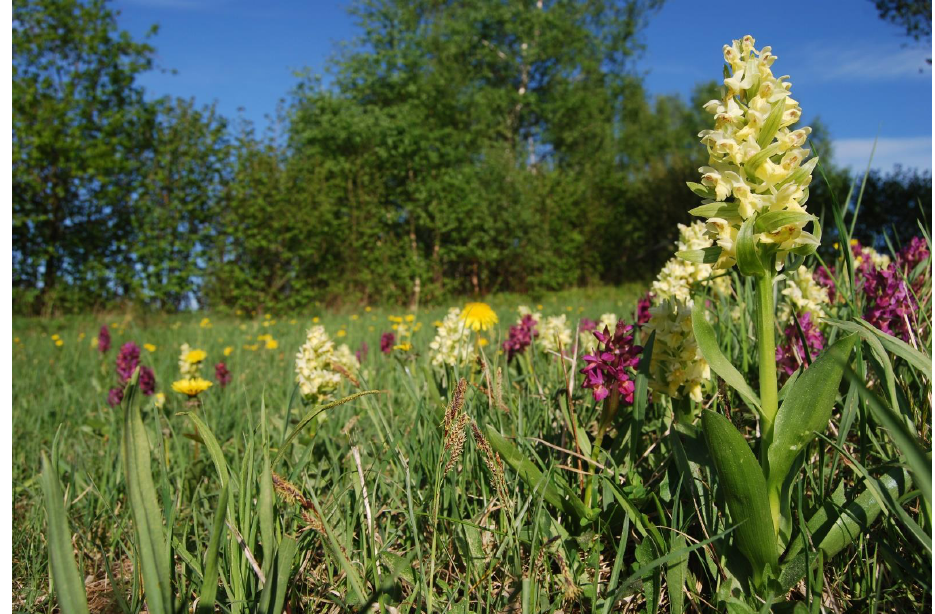
Figure 1. Dactylorhiza sambucina flowering in a Waldviertel population. The photograph shows yellow- and red-flowering individuals, which were monitored in ten different Lower Austrian populations to demonstrate natural flower morph fluctuations (photo credits: M. Kropf, 5 May